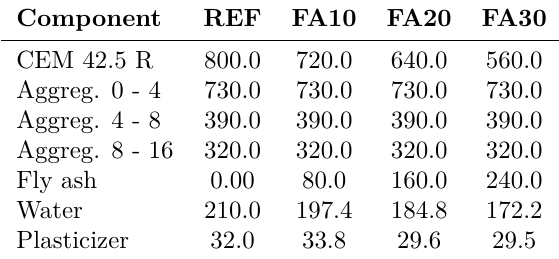
Table 1. Compositions of tested mixtures in [ kgm − 3